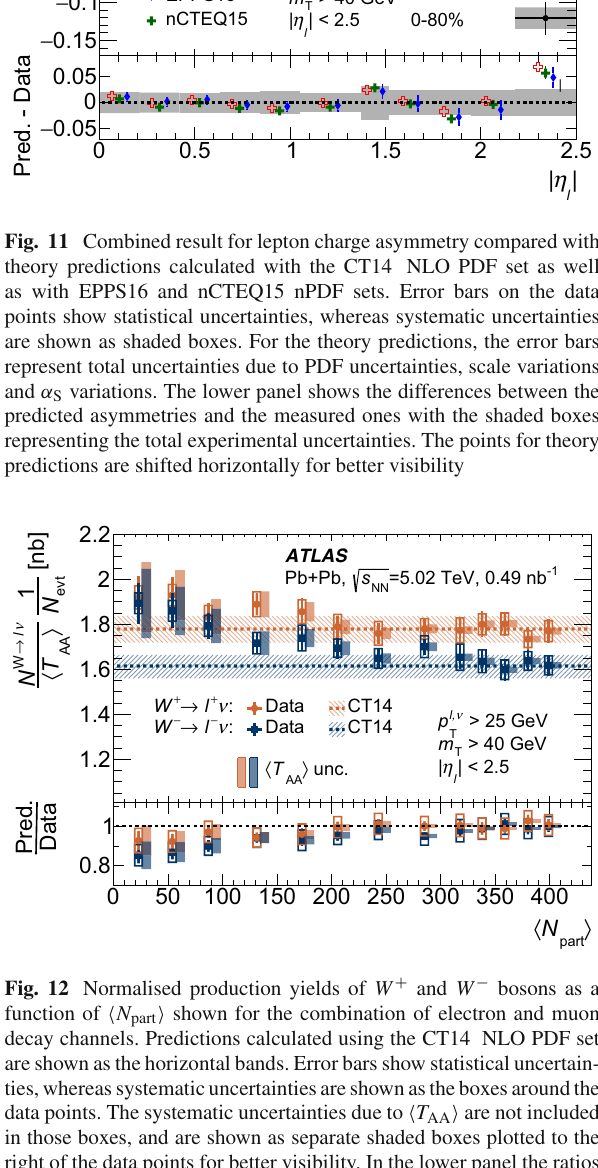
The measurement of normalised production yields for W + and W − bosons is repeated using the alternative FCal (cid:9) E T ranges to define centrality classes, N evt , (cid:4) N part (cid:5) and (cid:4) T AA (cid:5) values, extracted from the MCGlauber code v3.2. The